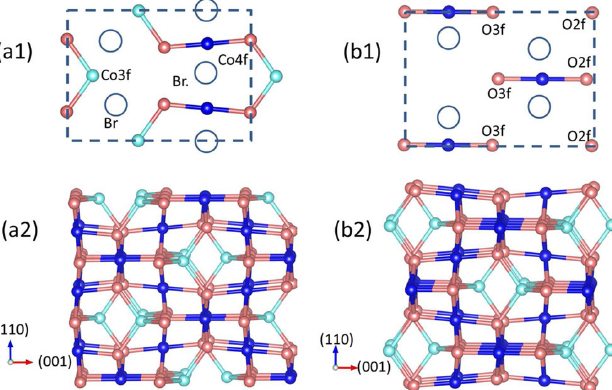
Figure 25. Stick-and-ball model of the Co 3 O 4 (110) surface structure. Top ( a1 , b1 ) and side ( a2 , b2 ) views of A ( left ) and B ( right ) terminations. In the top views, empty blue circles indicate water and hydroxyl group adsorption sites. Dark and pale-blue spheres indicate Co cations, which in the bulk are octahedrally and tetrahedrally coordinated, respectively. Red spheres indicate oxygen anions. (Reprinted from ref. [161] with permission from Journal of Physical Chemistry Letters. Copyright © 2012, American Chemical Society).